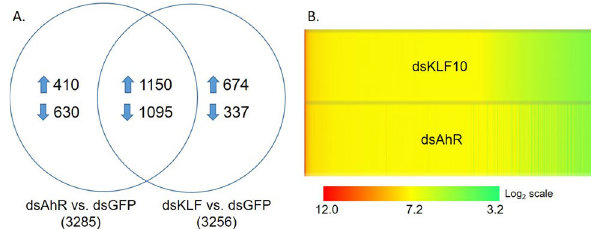
Figure 5. Expression patterns of the genes that were regulated by the AhR–KLF10 axis. ( A ) The distribution of altered genes by respective treatments. ( B ) The heatmap of transcript abundance (TPM) of the genes shared in the dsAhR and dsKLF10 cohorts.